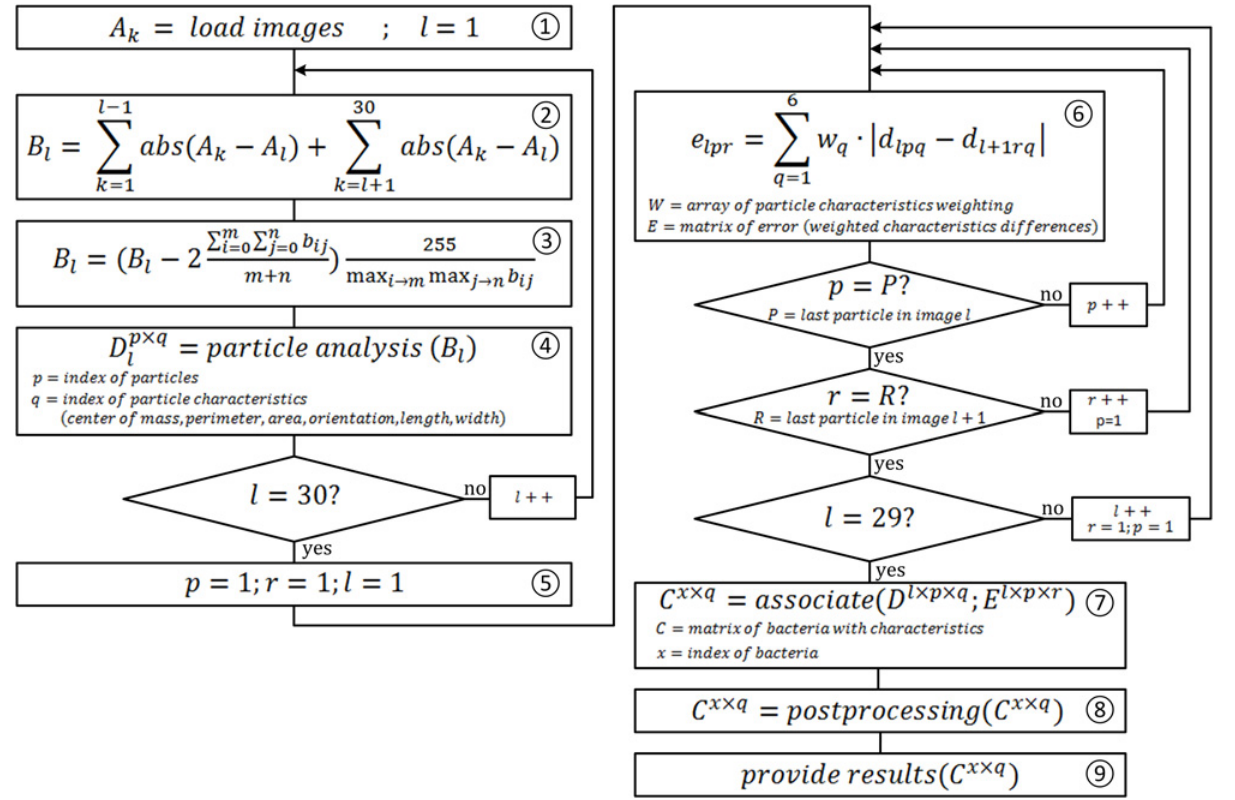
Fig 5. Simplified program flow chart of the image analysis. Simplified program flow chart of the image analysis. In step 1 the images are loaded, step 2 shows the indexed serial subtraction, step 3 the image preprocessing in step 4 the particle characteristics are determined, step 6 and 7 association of the bacteria with the characteristics, in step 8 the assignment is optimized before results are provided in step 9.